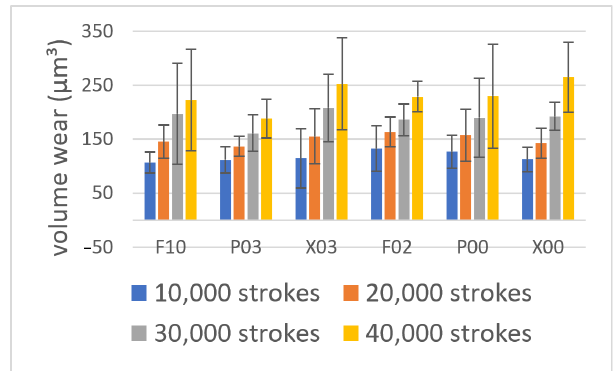
Figure 1. The wear volume of each flowable resin after the toothbrush abrasion test. The wear volume shows a tendency to increase linearly with the number of strokes during the test.